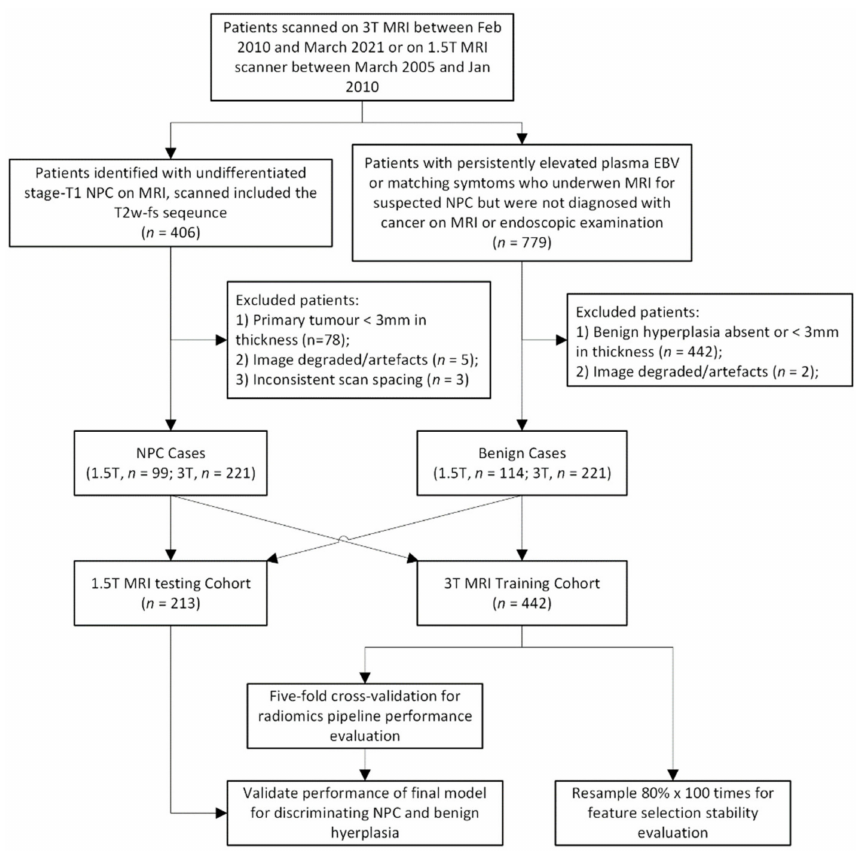
Figure 2. Flow chart showing the study process. NPC = nasopharyngeal carcinoma, MRI = magnetic resonance imaging, EBV = Epstein–Barr